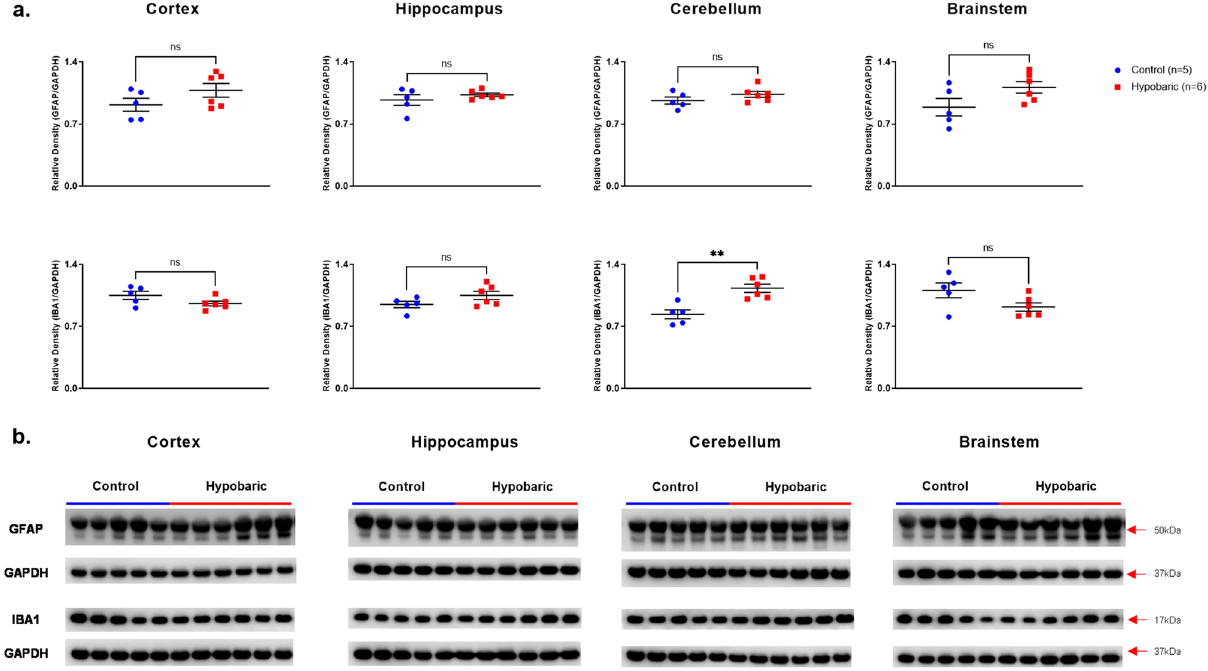
Figure 8. GFAP and IBA-1 Protein Expression Following Hypobaric Exposure. ( a ) Histograms representing the densitometric ratio of levels of GFAP and IBA1 with respect to GAPDH in the Control (blue spots) vs. HYPOBAR (red squares) group as measured in the frontal cortex, hippocampus, cerebellum and brainstem. All gels were run in duplicate and data represents the average of 2 runs per sample. Error bars represent standard error of the mean (SEM). * p < 0.05; ** p < 0.01 (two-tailed unpaired t -test). ( b ) Representative western blots for antibodies used. Full length blots are shown in Supplementary Figs. 3–9.